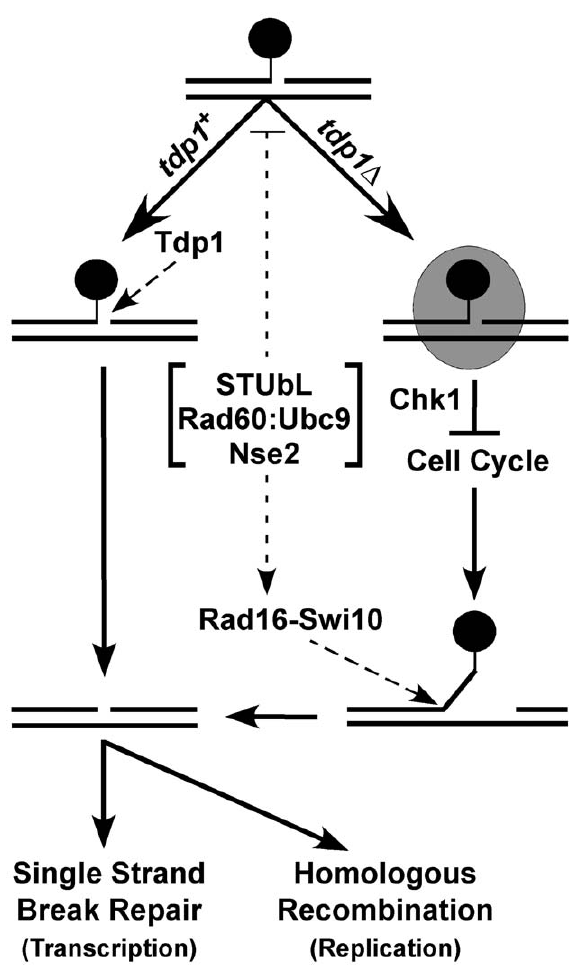
STUbL, Rad60:Ubc9, and Nse2. In wild-type cells, Tdp1 efficiently removes Top1cc (black circle), leaving a substrate for single strand break repair (SSBR) or homologous recombination (HR). In the absence of Tdp1, Top1cc is converted into a checkpoint visible lesion